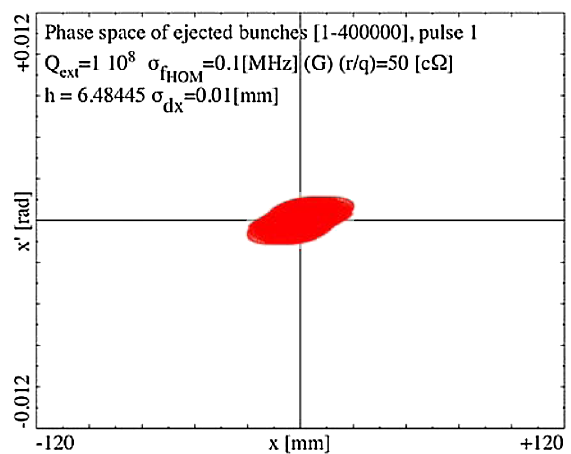
FIG. 57. (Color) Transverse voltage after the last bunch, con- ditions as in Fig. 54 (1st pulse).